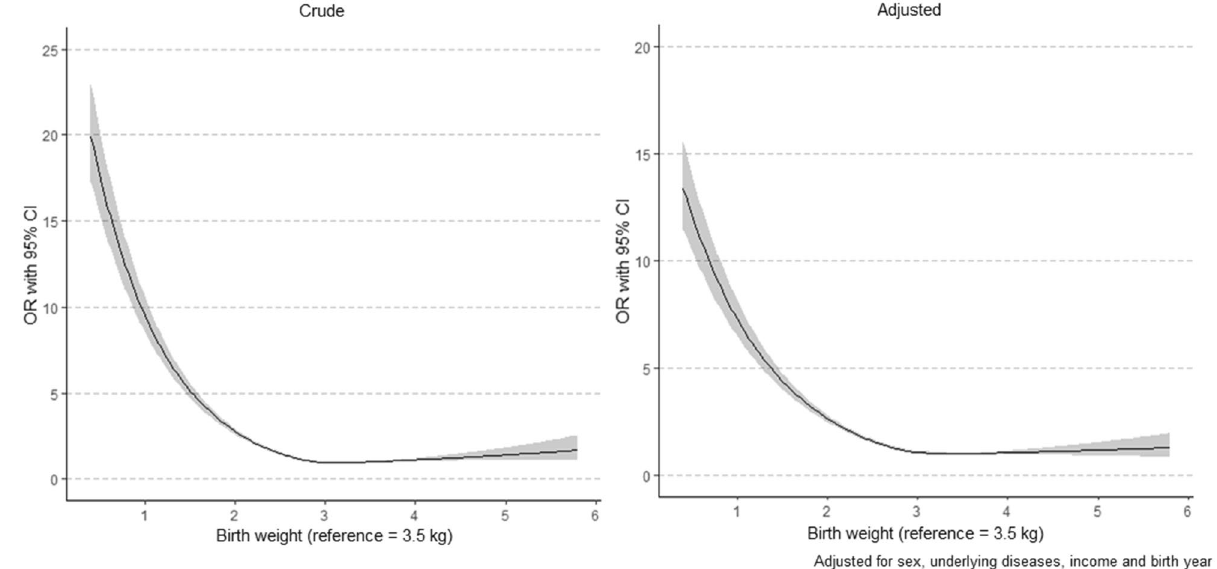
Figure 3. Crude and adjusted association between birth weight as a continuous variable expressed as cubic spline and